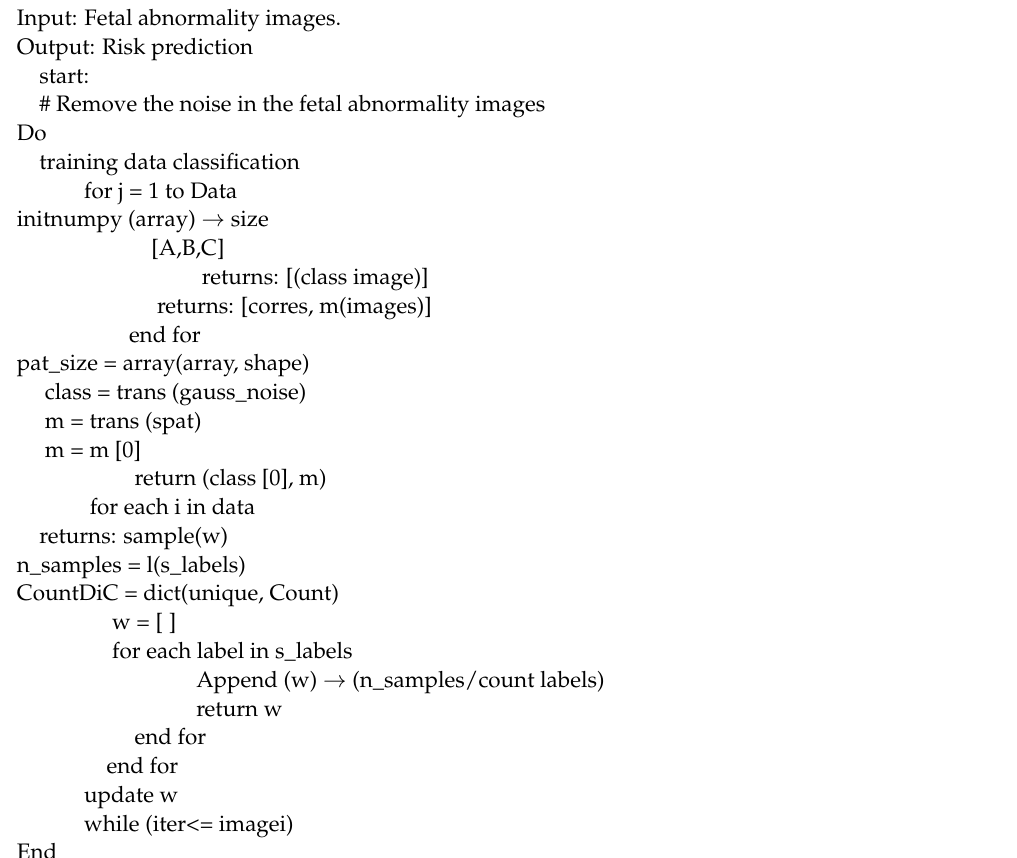
Algorithm 1: Adaptive Stochastic Gradient Descent